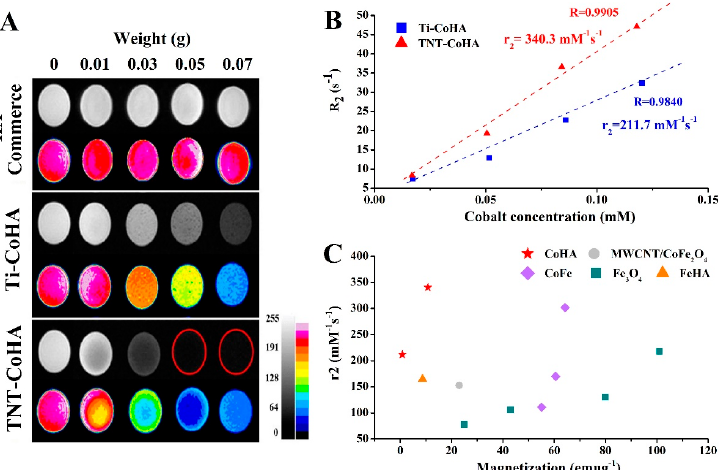
Figure 6. ( A ) T 2 -weighted MRI images of hydroxyapatite (HA) (commerce), CoHA, and TNT-CoHA suspended in gelatin at different concentrations. ( B ) The T 2 relaxation rate R 2 (1/T 2 ) against cobalt concentration of Co-HA. ( C ) Magnetic nanoparticle magnetization effects on relaxivity coefficient r 2 . Other magnetic nanoparticles data taken from MWCNT/CoFe 2 O [11], CoFe [20], Fe 3 O 4 [44], and FeHA